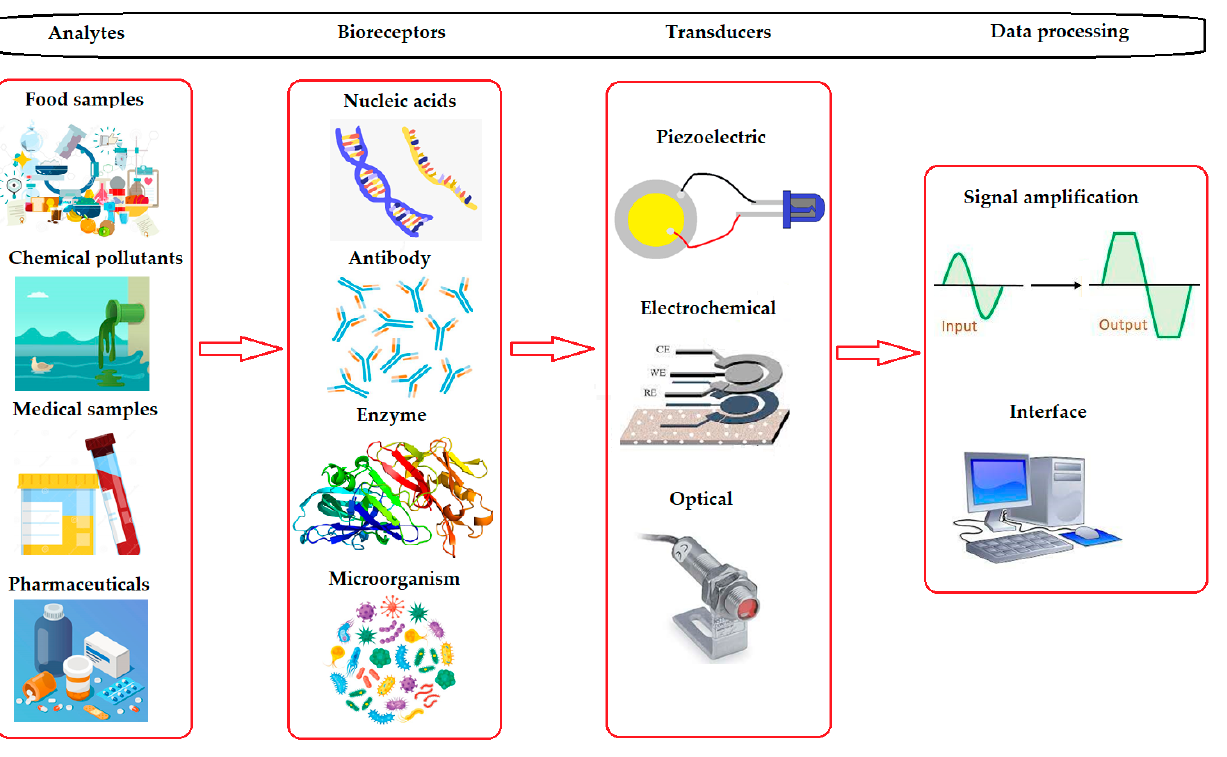
Table 1. Advantages and disadvantages of the main immobilization techniques.